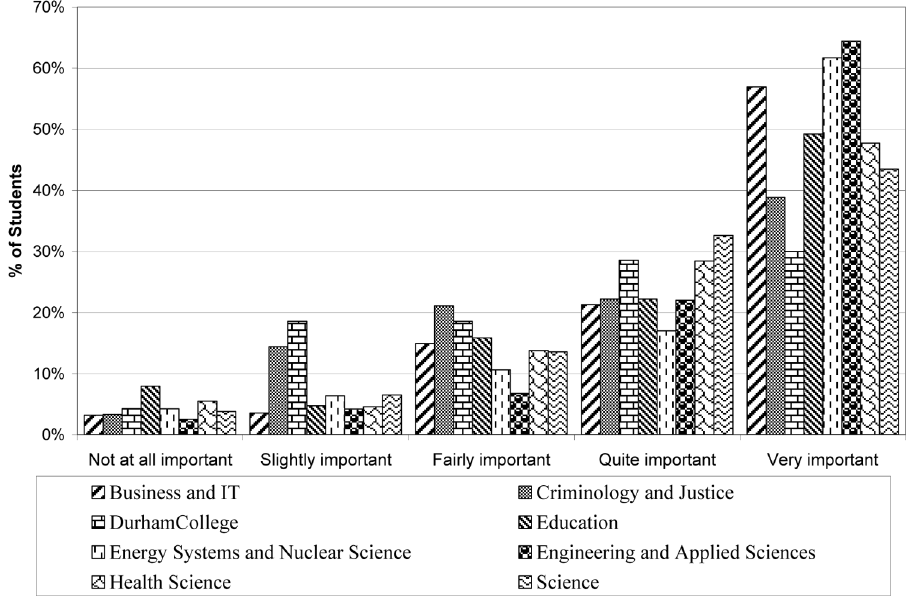
Figure 2. Perceived value by